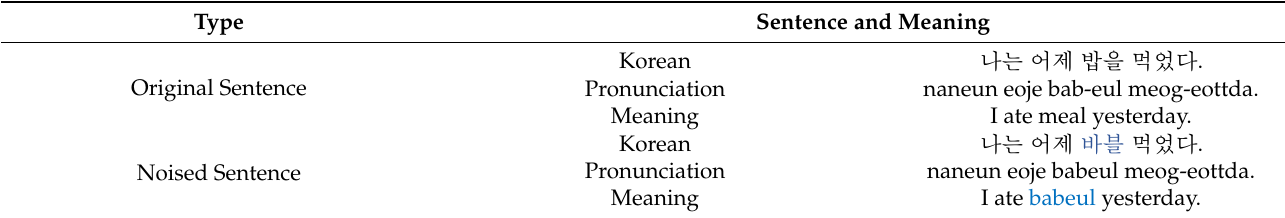
Table 2. Example of Noised Sentence by